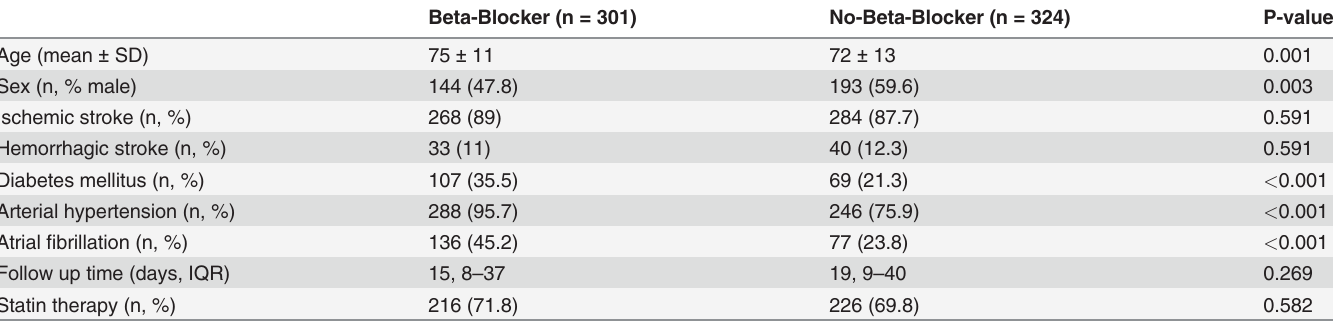
Table 1. Baseline characteristics of patients with and without beta-blocker therapy (n =